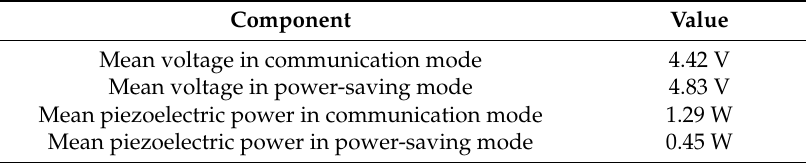
Table 7. Summary of the maximum power piezoelectric harvester results.